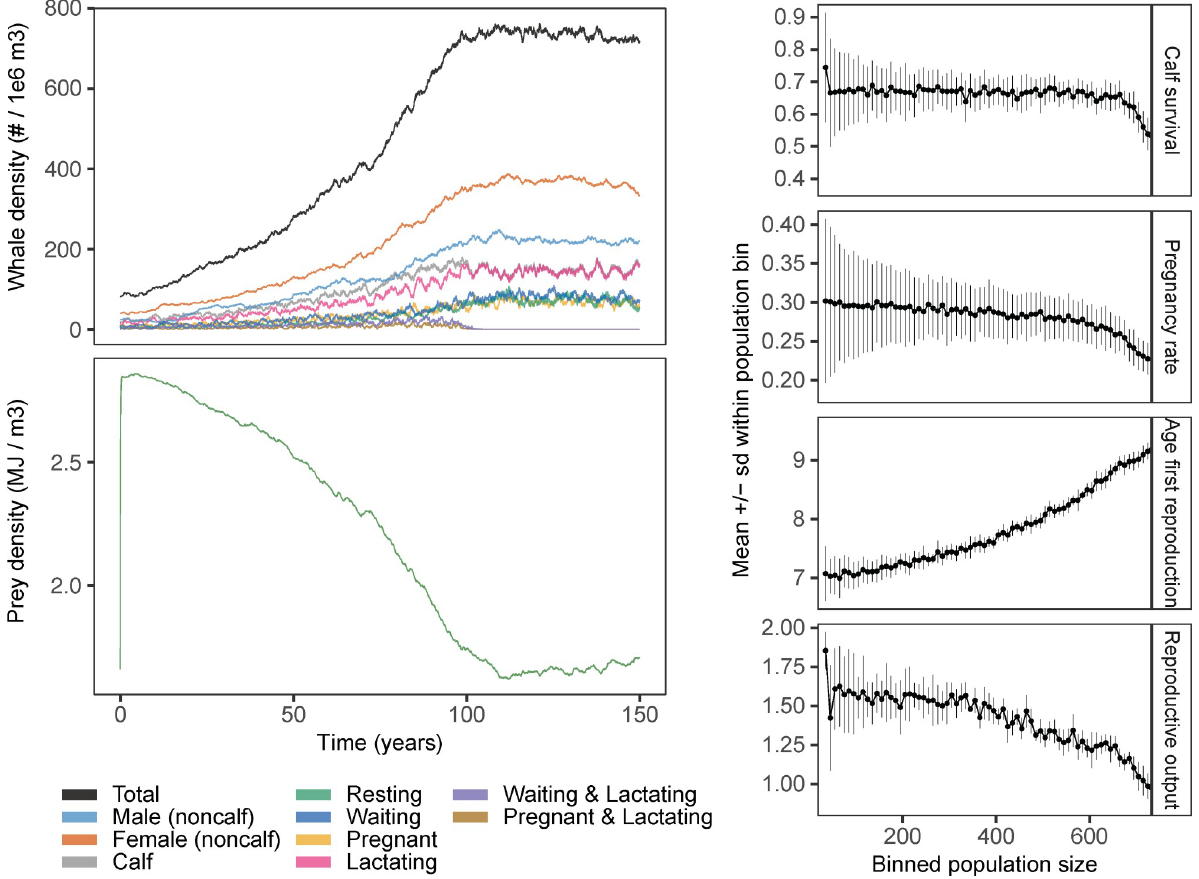
Fig 1. Density-dependent population dynamics. Changes in whale and prey densities and whale vital rates associated with the approach of the whale population to a stationary state. Left panels show the outcome of a single simulation with whale densities colored according to sex and reproductive status (for females only). Right panels show the mean +/- standard deviation of calf survival, pregnancy rate (ratio of pregnant to mature (i.e. age > 8 yrs.) females), female age at first reproduction (yrs.) and female lifetime reproductive output as a function of binned population size (80 bins of size 10 ranging from 0 to 800), derived from 100 replicate simulations. All replicate simulations were initialized with a unique stationary state at a mean annual prey productivity of K = 0.09 MJ m -3 day -1 . Subsequently, K was increased to 0.15 at time zero for each simulation. All other parameters at default values (Table 1 in S1